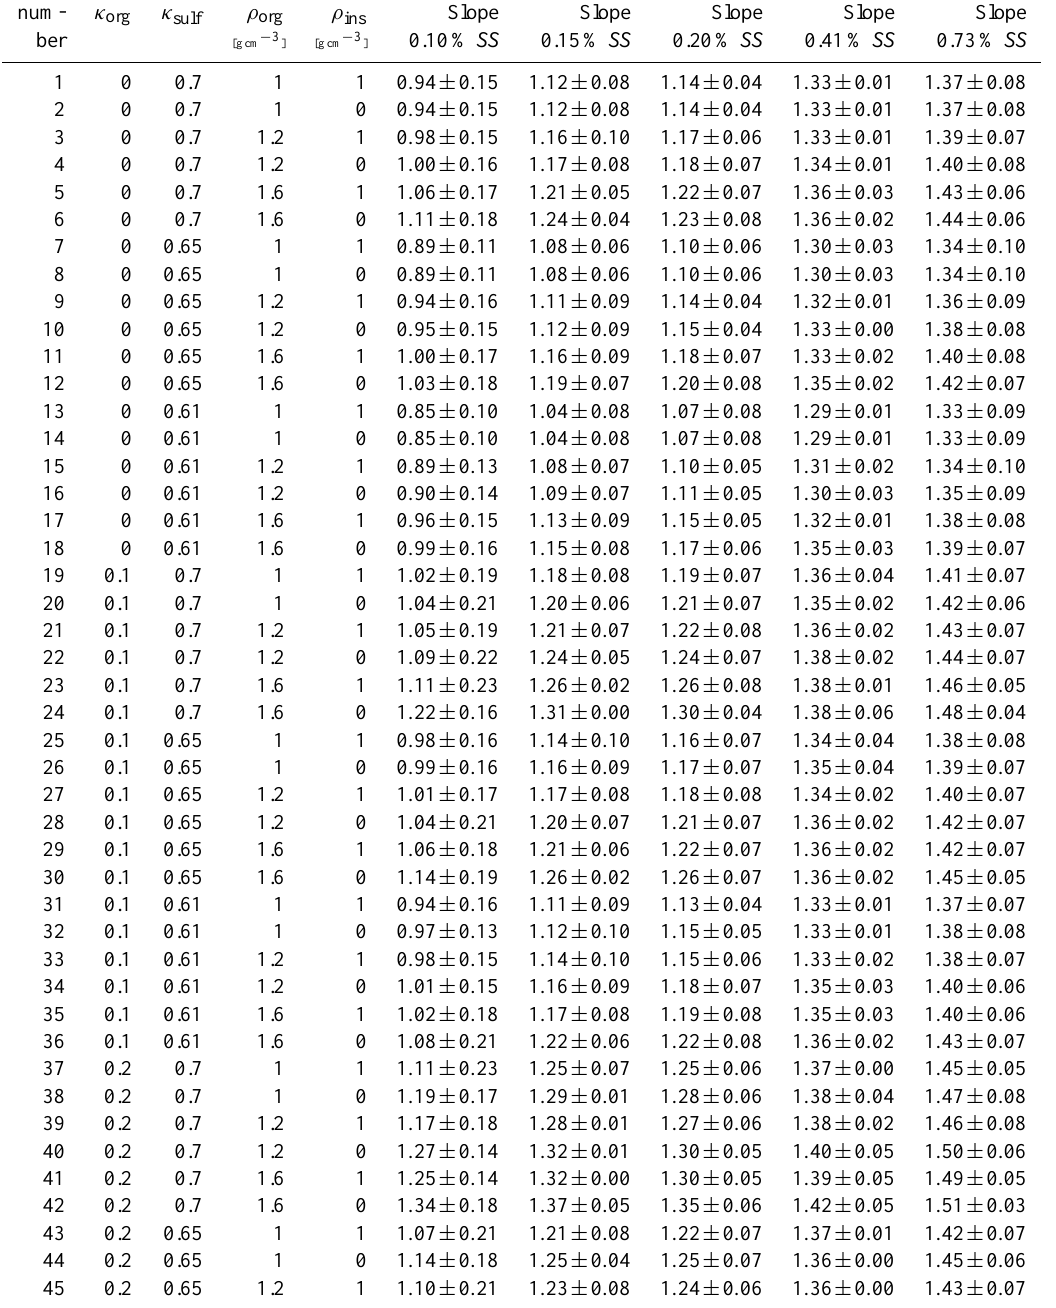
Table A1. Table with the different parameter settings for the performed closure studies and the resulting slopes for the five super- saturations. (Settings 1–2, 7–8, 13–14, 91–92, 97–98, 103–104, 181–182, 187–188, 193–194, 271–272, 277–278, 283–284,